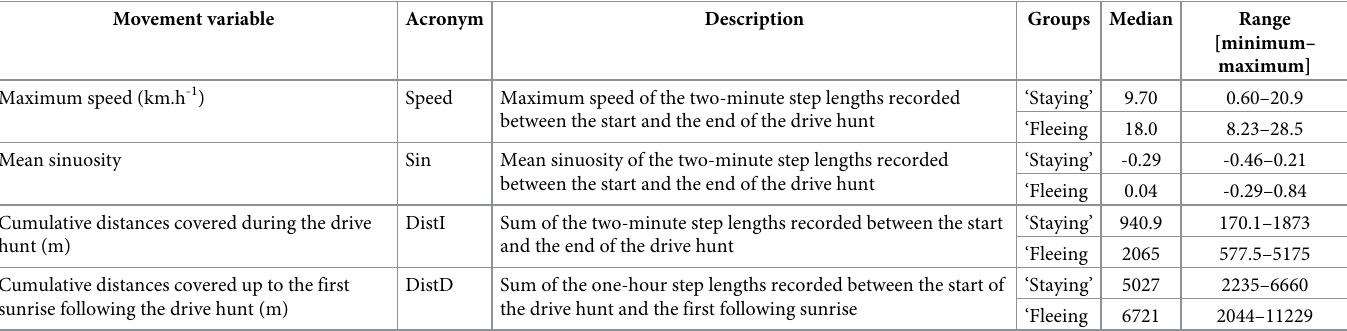
Table 2. Median values and range of the four movement metrics used to describe movement paths of red deer in the National Estate of Chambord, France, 2016– 2018. All these metrics were obtained using data from GPS collars (based on one location every other minute for the first three and one location every hour for the fourth). Values were then calculated for the two groups of individuals: (a) ‘staying’ (32%) and (b) ‘fleeing’ (68%) discriminated based on the immediate phase of their response ( i . e . whether the individual crossed the shooting line and moved out of the hunted area during the drive hunt or